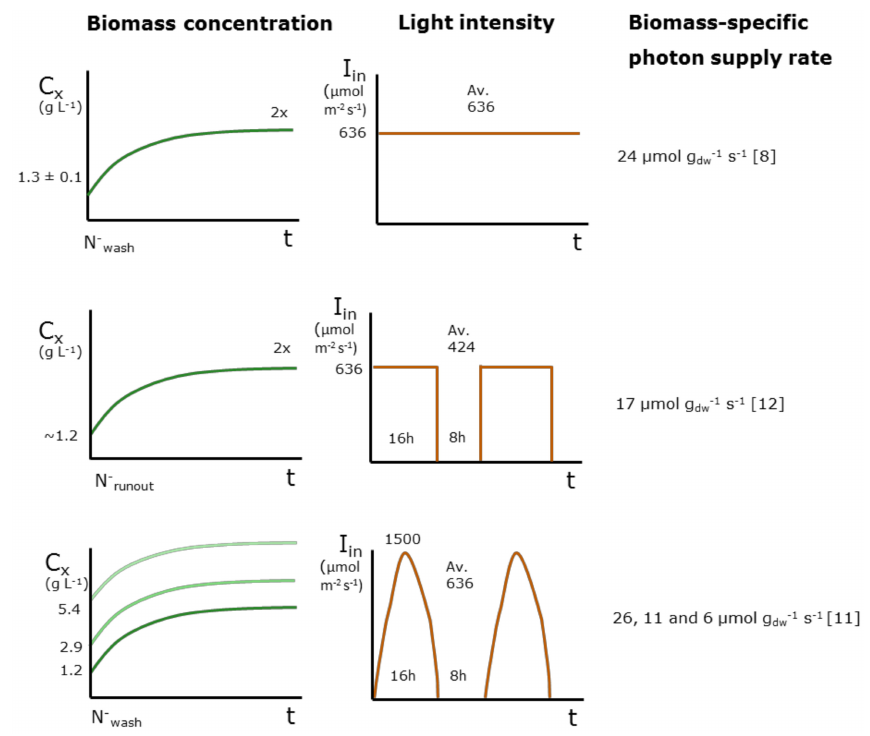
Figure 1. Overview experimental conditions used; light regime, average light intensity per day ( µ mol m − 2 s − 1 ) and biomass concentration (g L − 1 ) at the onset of nitrogen starvation with their respective average initial biomass-specific photon supply rates ( µ mol g dw − 1 s − 1 ) at the start of nitrogen starvation